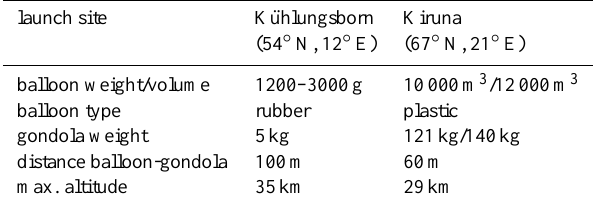
Fig. 5. Time record (converted to altitude) of the measured voltage fluctuations during the BEXUS 6 flight on 8 October 2008. Between 26500 and 26800 the gondola passes a turbulent layer, which is defined by sharp boundaries to the non-turbulent